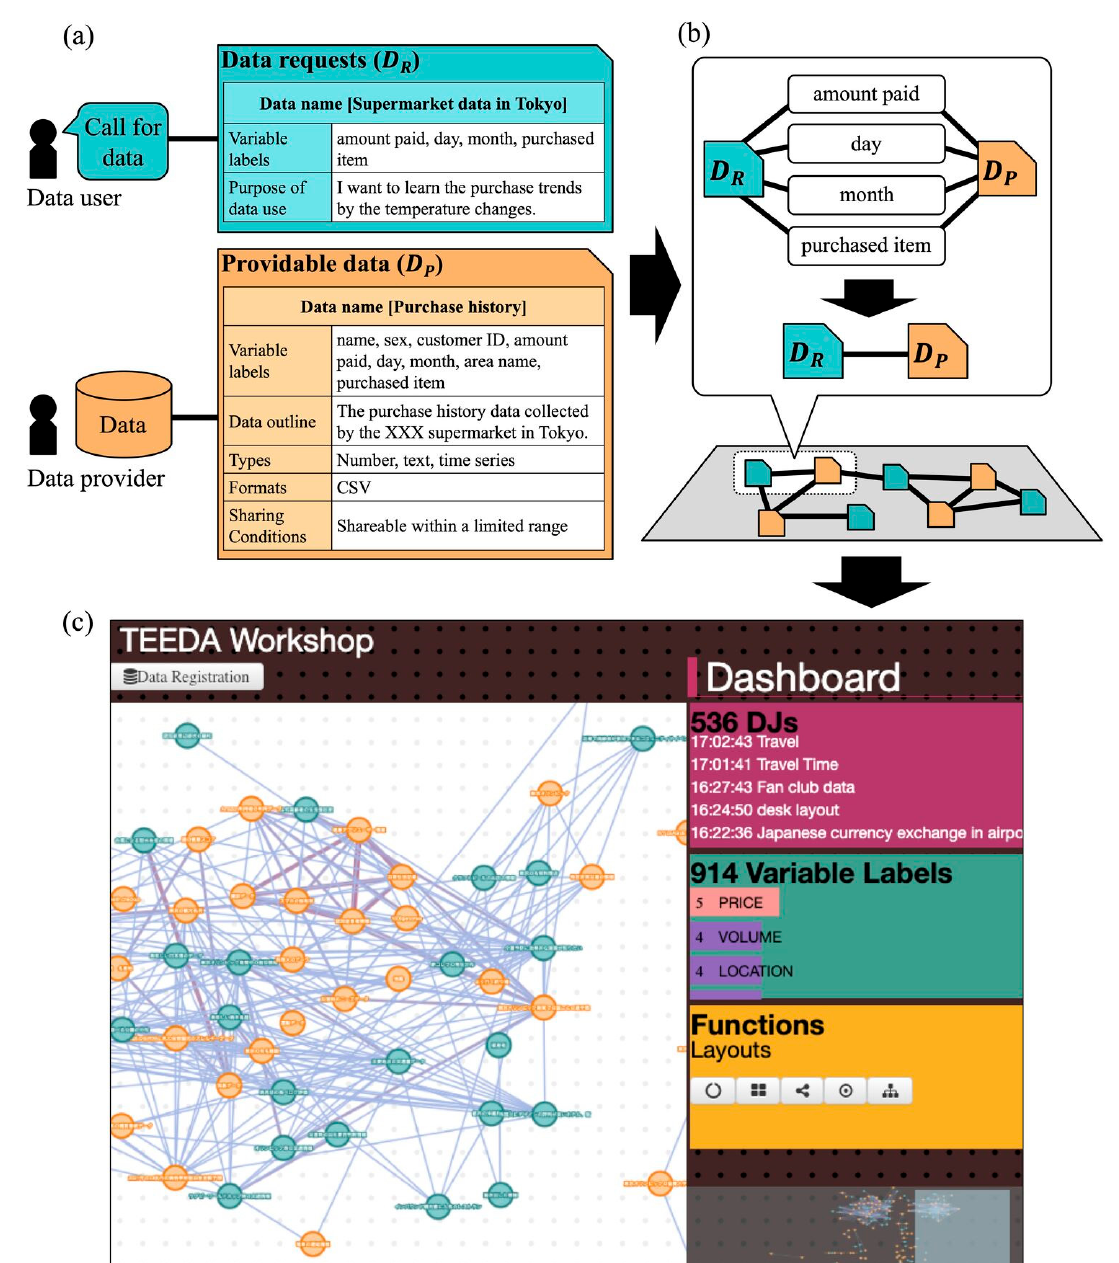
Figure 1. The process of ( a ) collecting and ( b ) matching data requests and providable data, and ( c ) the TEEDA